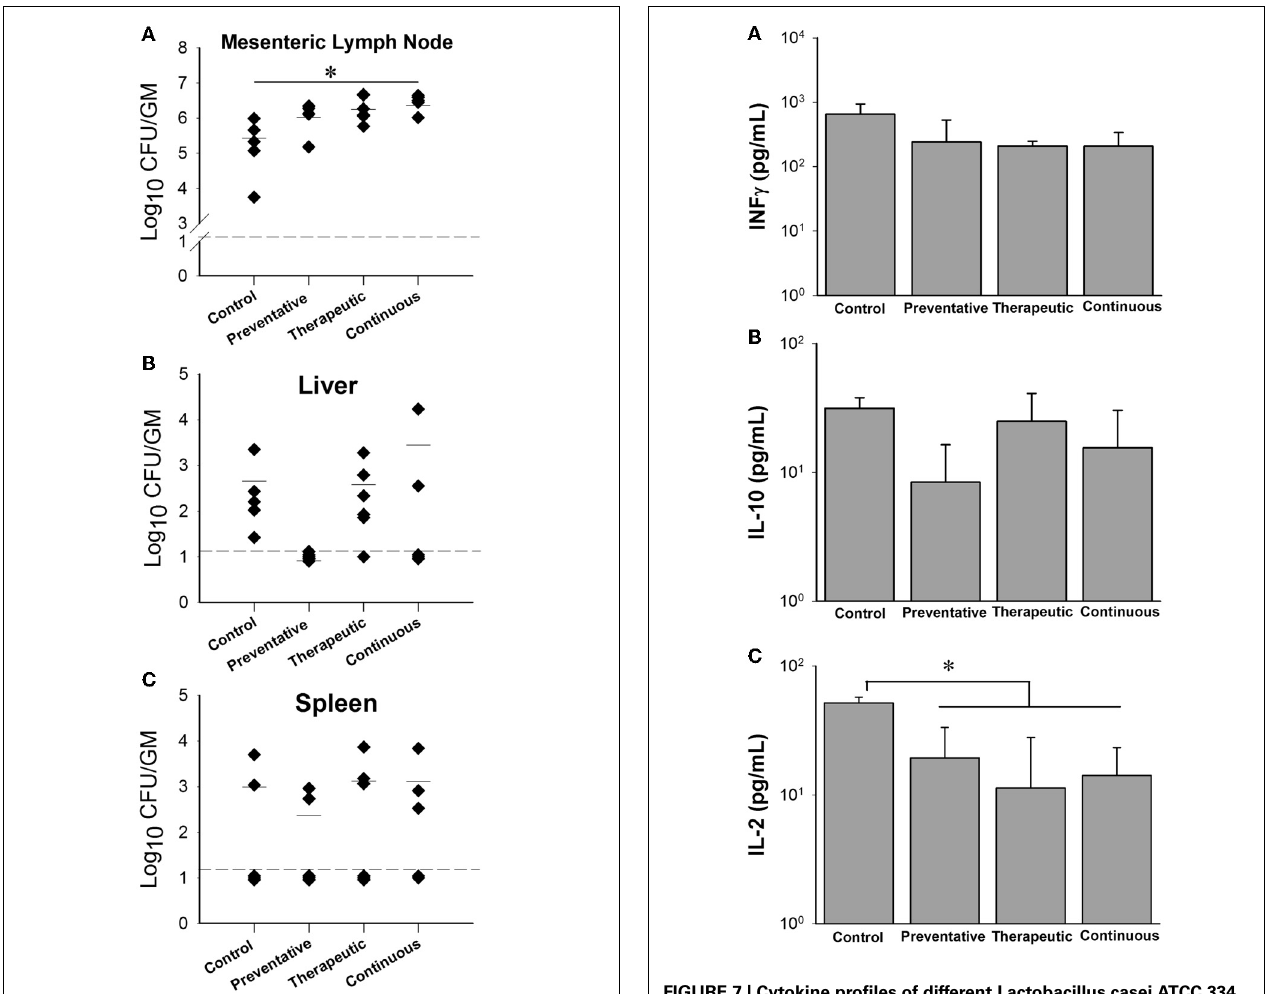
FIGURE 6 | M. avium subsp. paratuberculosis organ colonization from different Lactobacillus casei ATCC 334 treatments at 12 weeks post oral M. avium subsp. paratuberculosis K10 infection. Graphs (A–C) ( A -Mesenteric lymph node, B -Liver, C -Spleen) depict the CFU/g of M. avium subsp. paratuberculosis obtained from the homogenized organs (mesenteric lymph node, liver and spleen) of mice treated with different ATCC 334 treatments and orally challenged with two doses of 10 9 CFU M. avium subsp. paratuberculosis K10. Each dot represents one mouse, the hash mark denotes the mean, and the dotted line represents the minimum detection limit. ( ∗ p < 0 . 05).